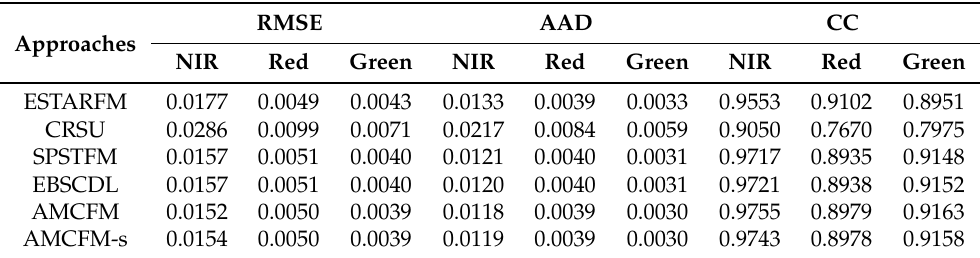
Table 3. Band quality metrics in image 1.